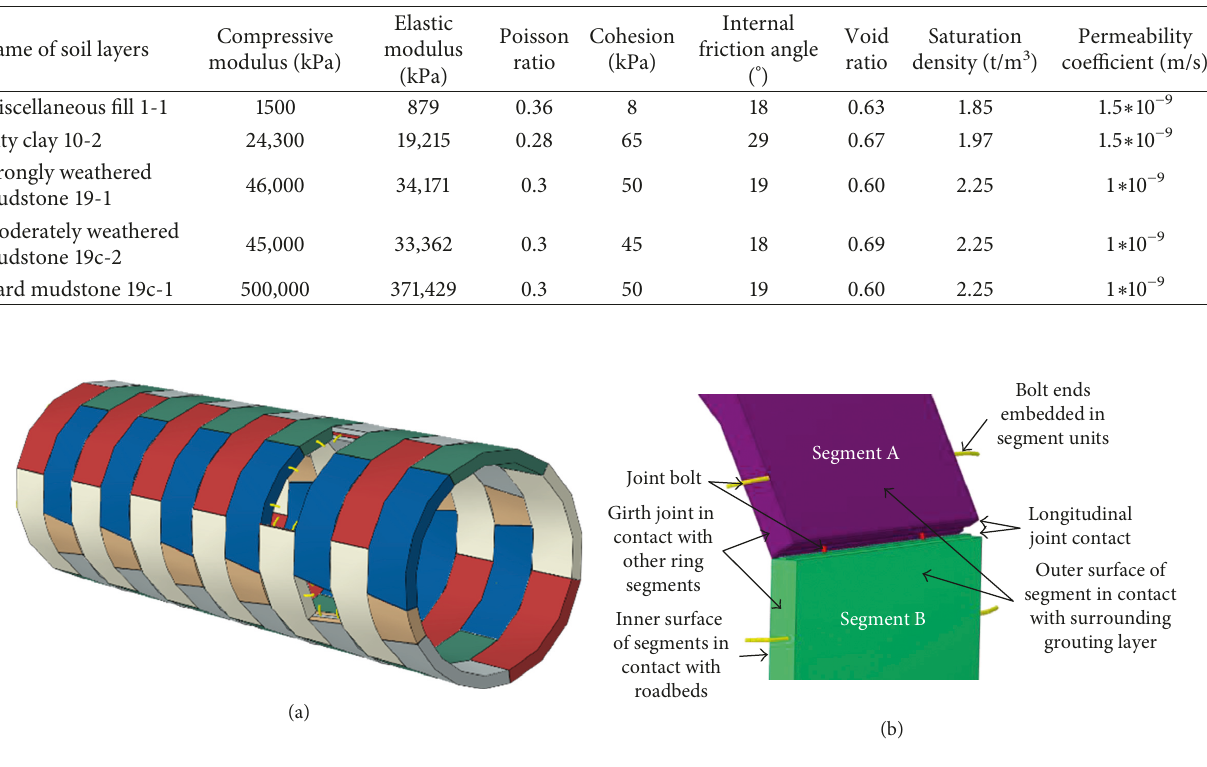
Figure 4: The contact relationship among the grouting layer, segment, and the surrounding rocks. (a) Model of the segmental lining. (b) 3D contact